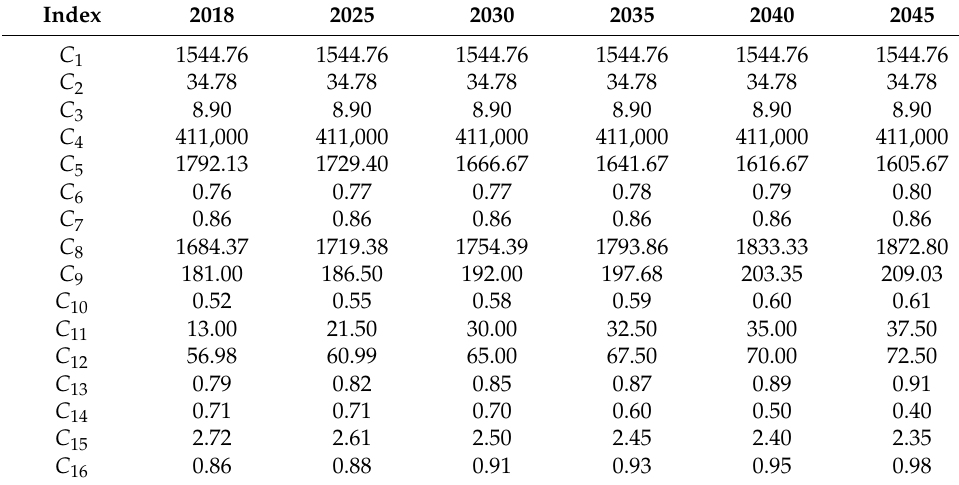
Table 5. Evaluation index value of the water resource scarcity in